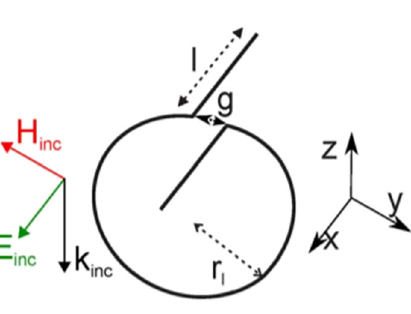
Figure 14: Geometry of single Chiral particle for reciprocal twist polarizer (reprinted with permission from Ref.